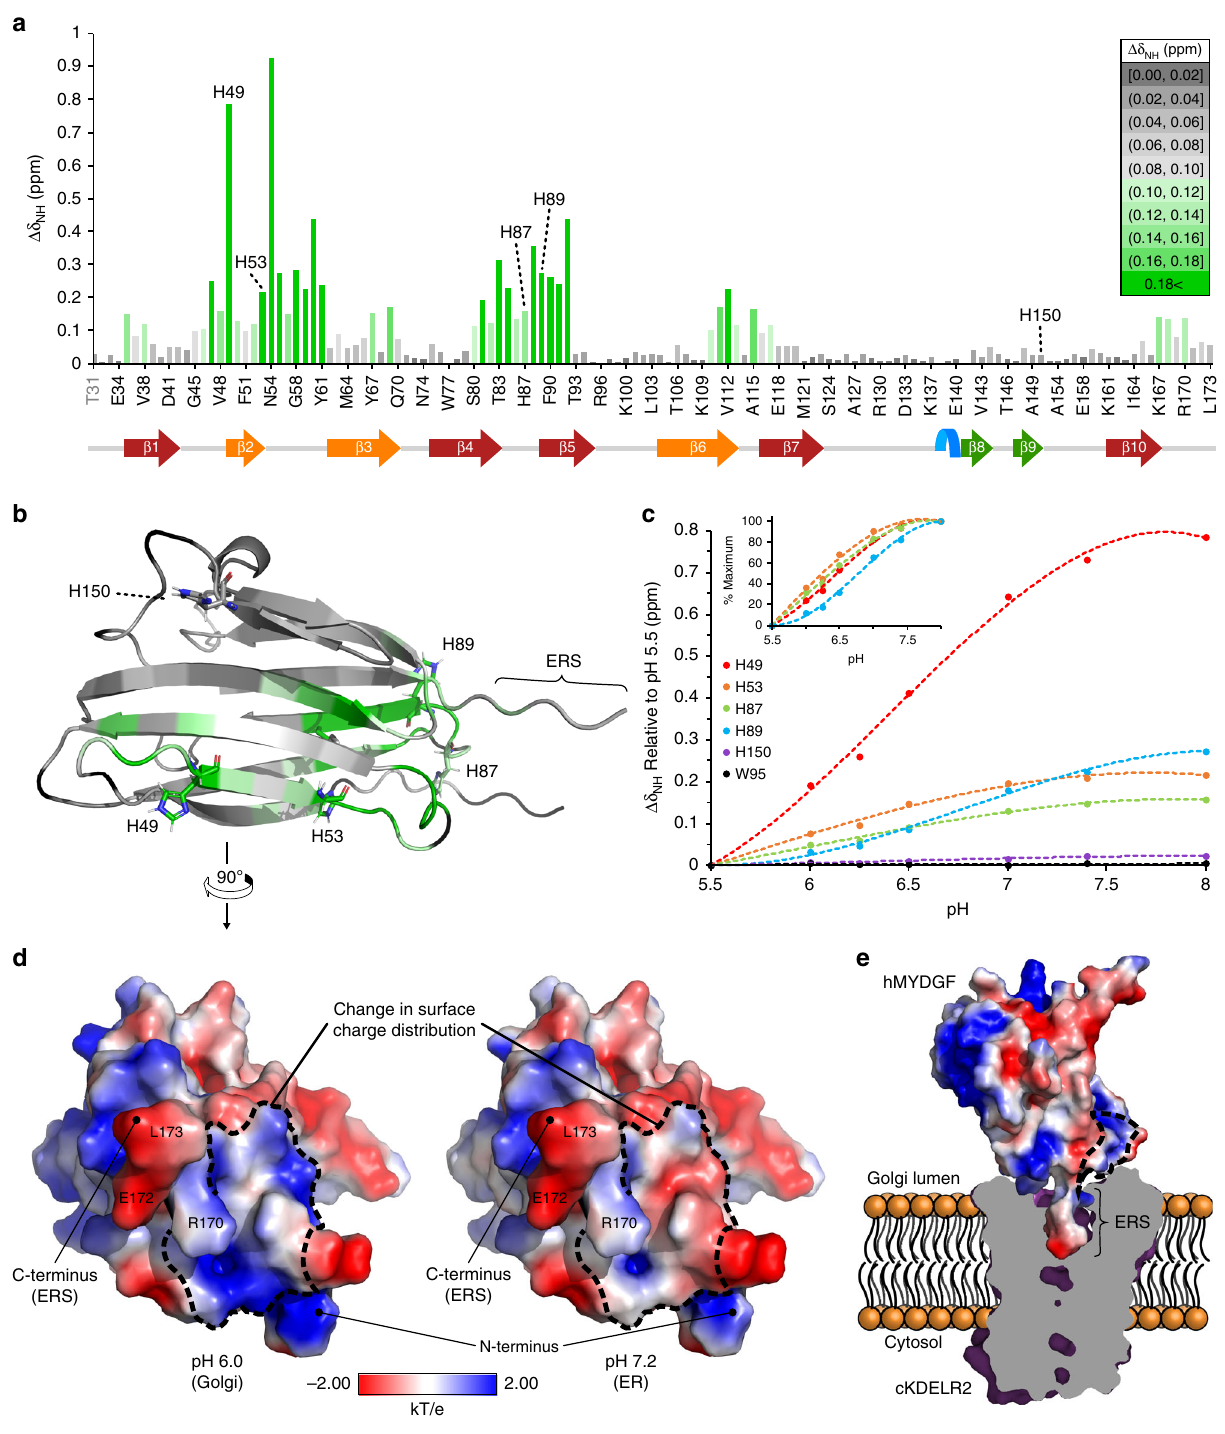
hMYDGF (Fig. 5a; residues from the cloning artifact are not shown). Among the most conserved residues are the two cysteines (Fig. 5a, center of the β -sandwich) and the two C- terminal residues that comprise the ERS. The ERS extends from an edge of the β -sandwich that contains predominantly variable residues (Fig. 5b). In contrast, the protein surface opposite the ERS, consisting of β 1/ β 2, β 3/ β 4, β 5/ β 6, and β 9/ β 10 loops, contains highly conserved residues (Fig. 5c). Underneath the surface of this conserved face between the β -sheets of the β - sandwich is an apparent cavity for which NOE interactions